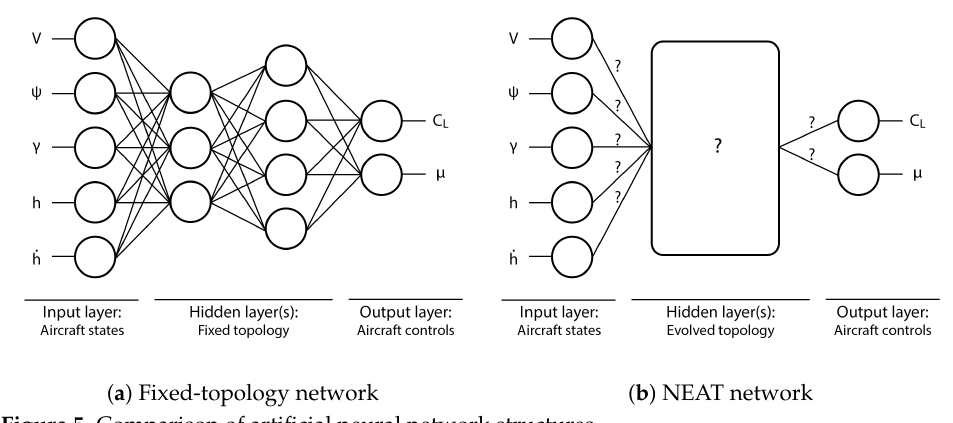
Figure 5. Comparison of artificial neural network